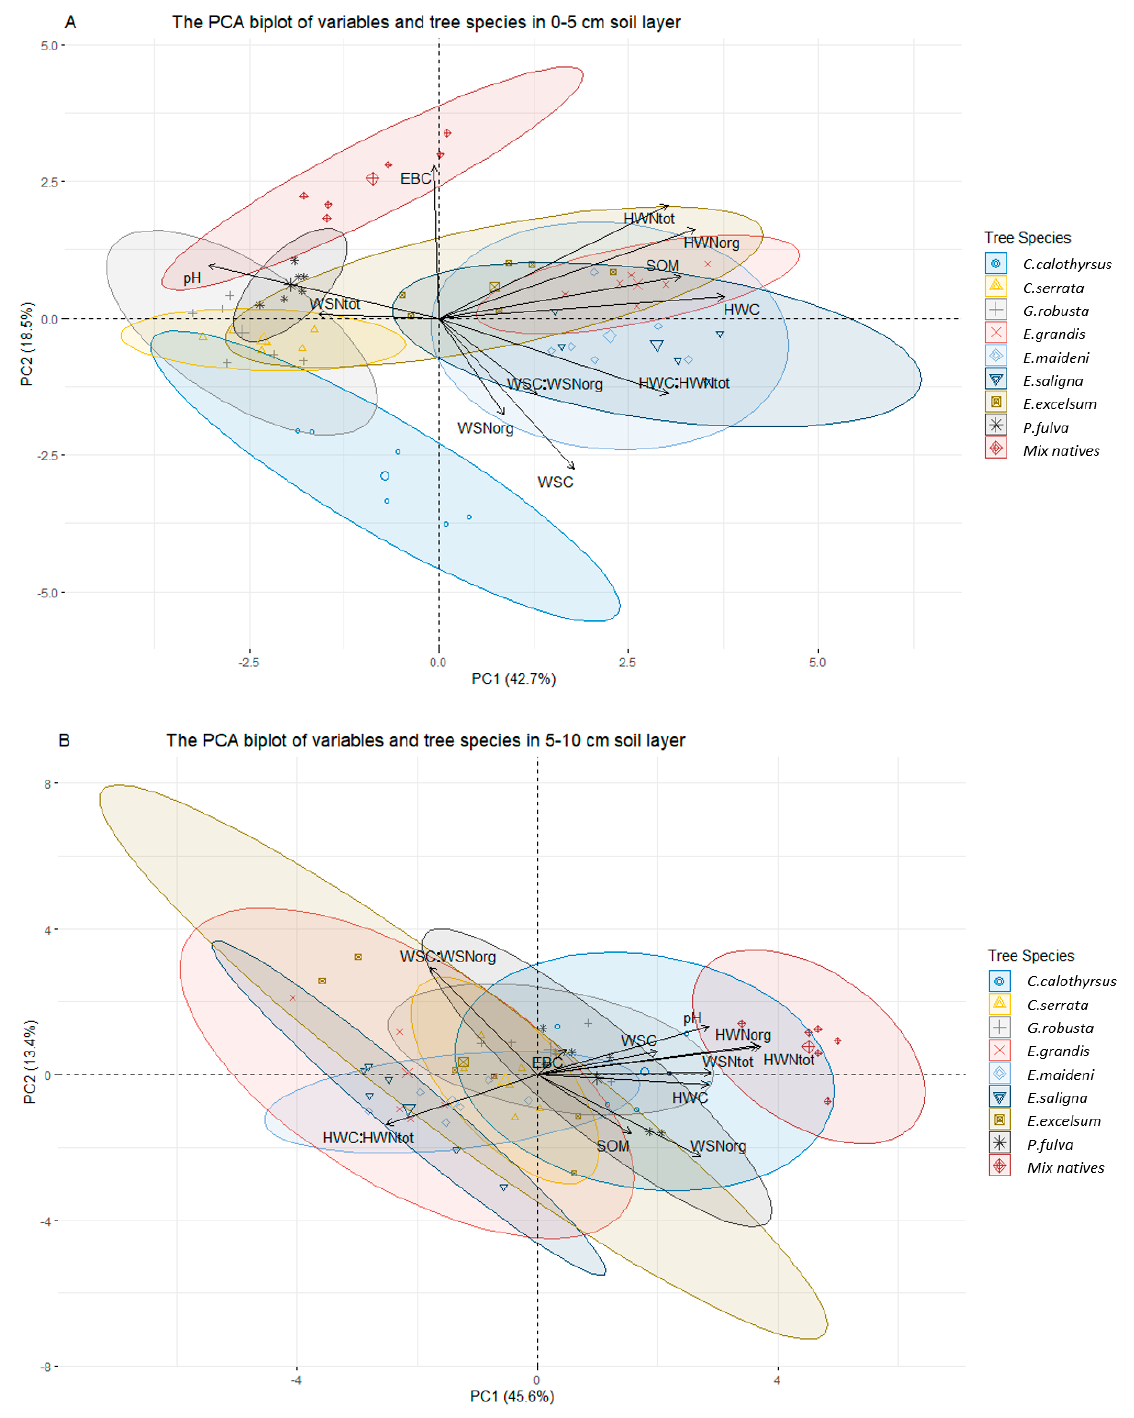
Figure 5. PCA biplot of soil chemical properties and tree species for the upper ( A ) and the lower ( B ) soil layers. The first two principal components explained 62.5% of the combined variation in soil parameters at 0–5 cm soil depth and 54.9% at 5–10 cm soil depth between tree species. Statistical ellipses at 95% confidence level group tree species (represented by different symbols and colors) based soil variables depicted by vectors (pH; SOM = soil organic matter; EBC = exchangeable basic cations; WSC = water-soluble C, WSN org = water soluble organic N; WSNtot = water-soluble total N, WSC:WSN org = water soluble organic C/N ratio; HWC = hot water-extractable C, HWN org = hot water-extractable organic N, HWNtot = hot water-extractable total N, and HWC:HWNtot= hot water-extractable C/N